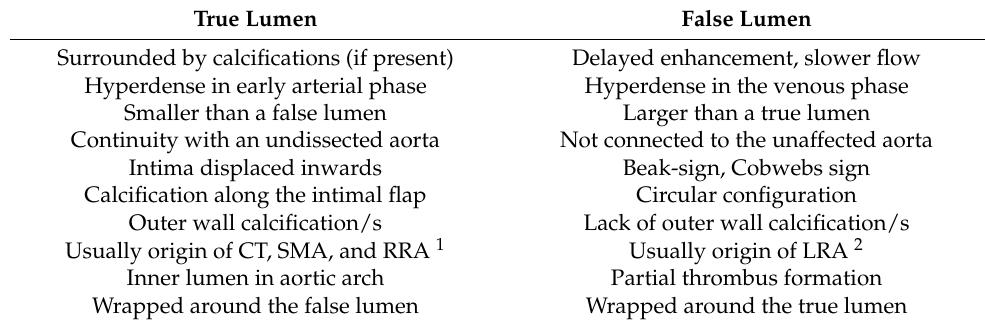
Table 4. CTA findings to differentiate true and false lumen. True Lumen False Lumen Surrounded by calcifications (if present) Delayed enhancement, slower flow Hyperdense in early arterial phase Hyperdense in the venous phase Smaller than a false lumen Larger than a true lumen Continuity with an undissected aorta Not connected to the unaffected aorta Intima displaced inwards Beak-sign, Cobwebs sign Calcification along the intimal flap Circular configuration Outer wall calcification/s Lack of outer wall calcification/s Usually origin of CT, SMA, and RRA 1 Usually origin of LRA 2 Inner lumen in aortic arch Partial thrombus formation Wrapped around the false lumen Wrapped around the true